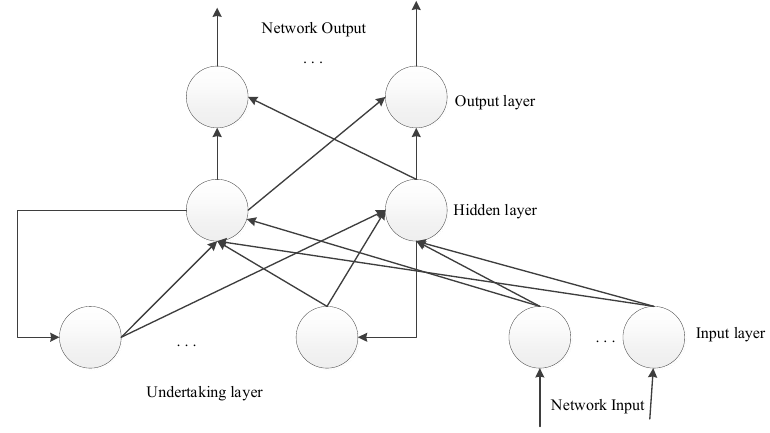
Figure 9. The model structure of Elman neural network.